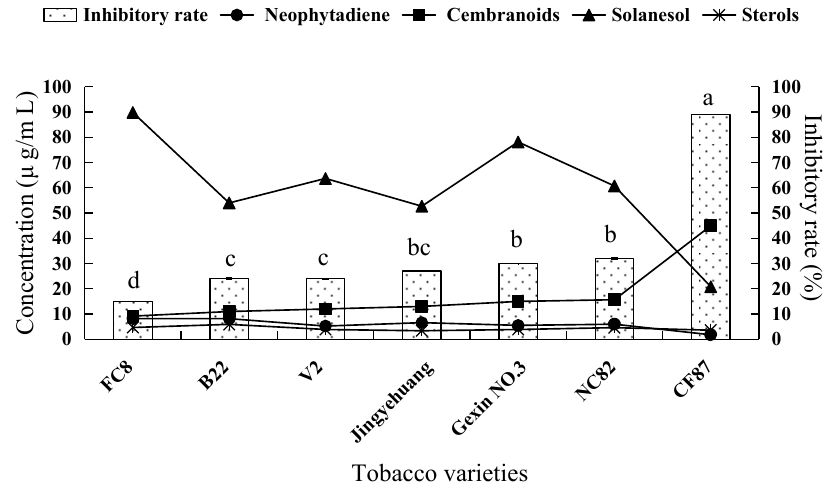
Figure 2. Inhibitory rate against V. mali and the concentration of terpenes in different tobacco variety extracts. Columns with different letters represent varieties with significantly different values according to Duncan’s multiple range tests at p < 0.05.